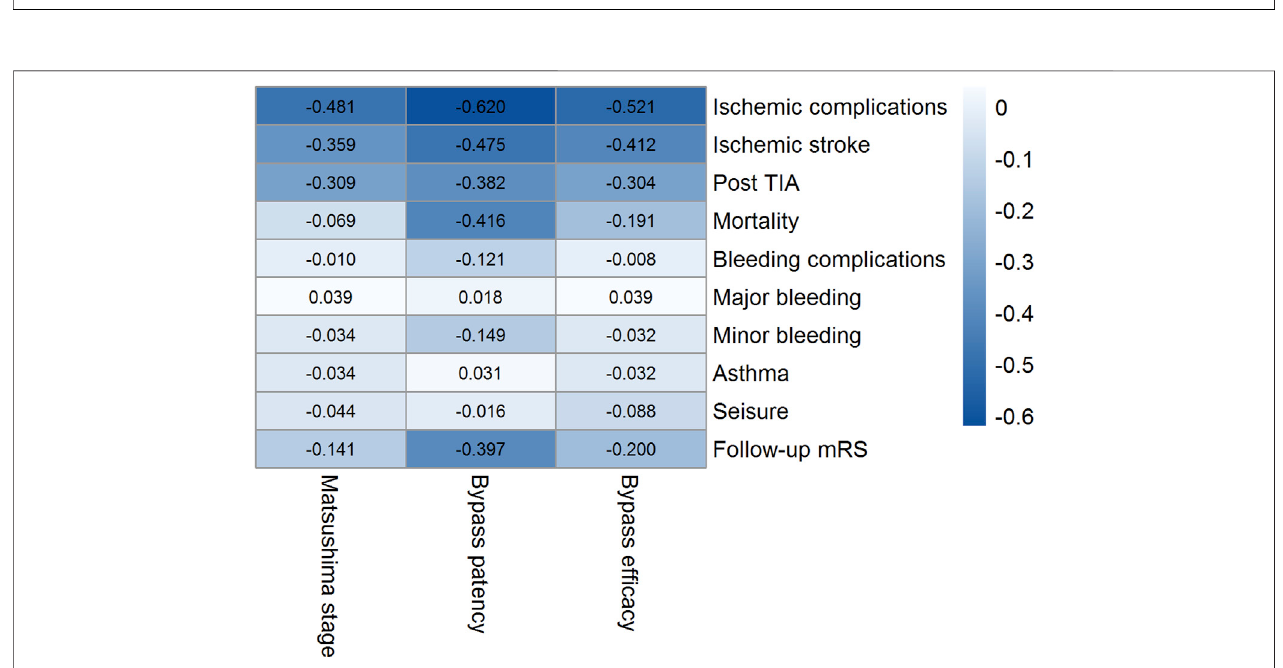
FIGURE 4 | Correlogram of bypass ef fi cacy and postoperative complications by study visit. Correlations were strong between the level of bypass ef fi cacy and the rate of ischemic complications.